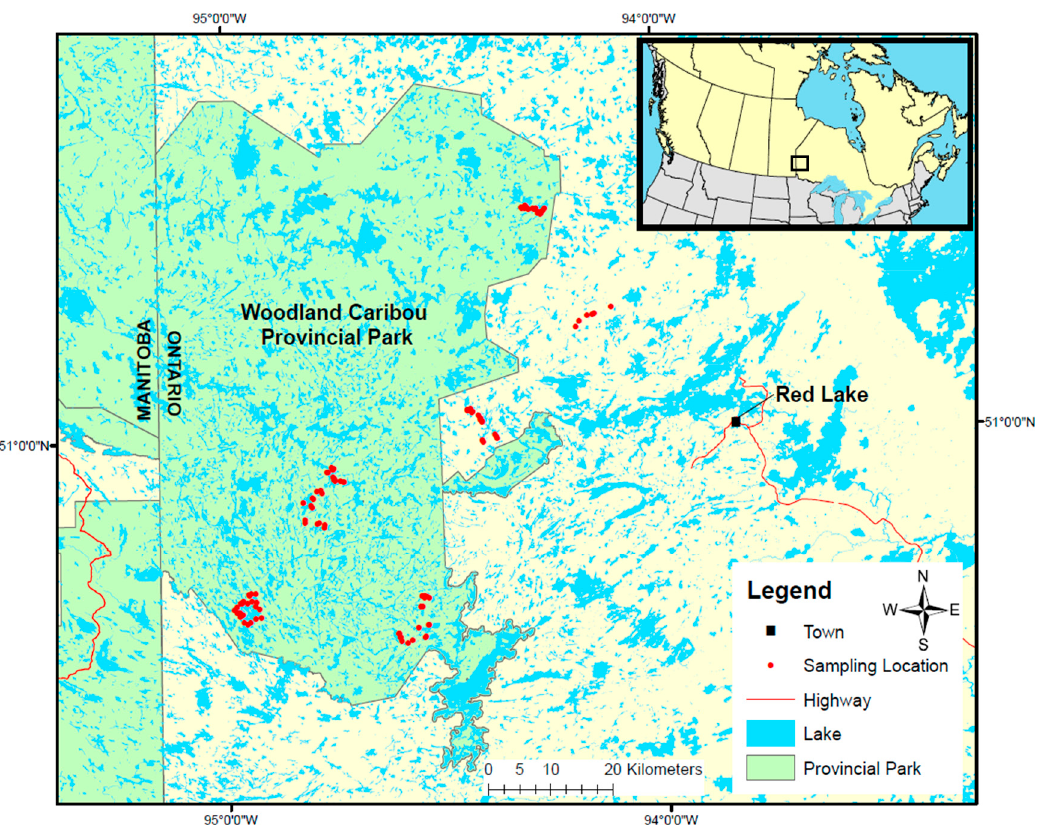
Figure 1. Location of the study area in northwestern Ontario, Canada. Sampling locations, indicated by red dots, are concentrated in and around Woodland Caribou Provincial Park, west of the town of Red Lake.